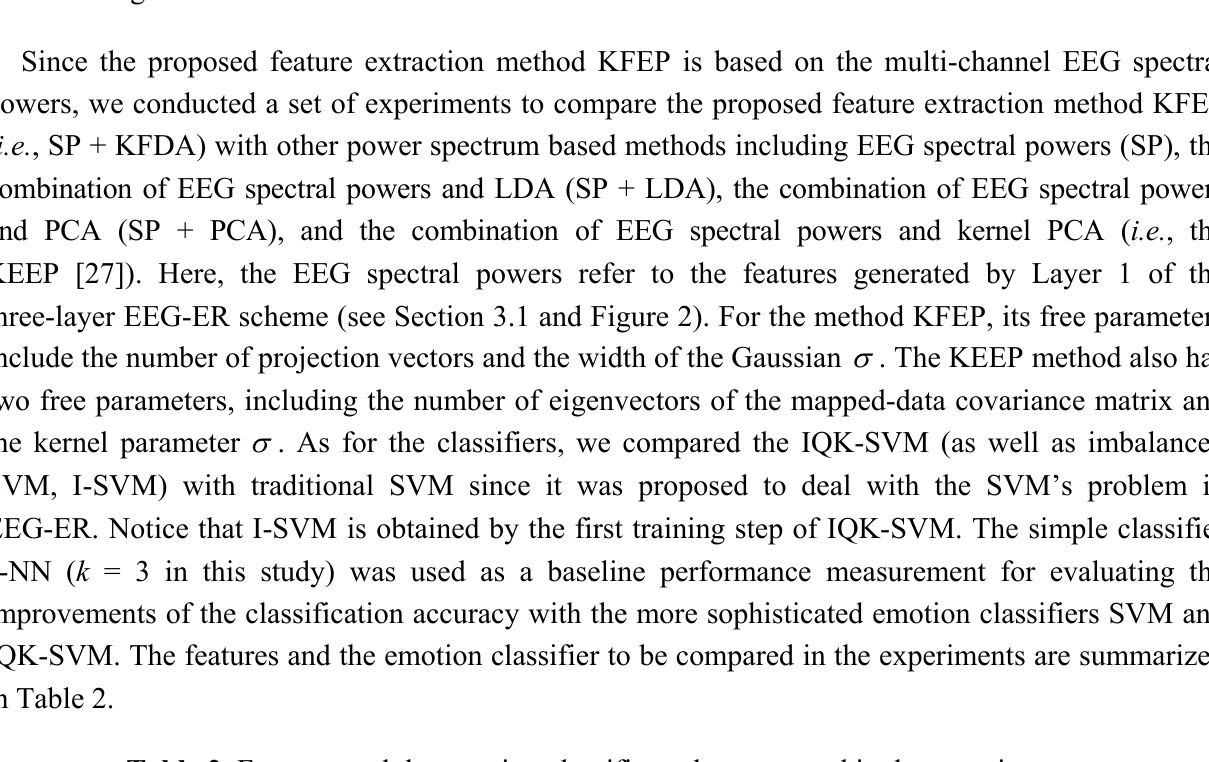
Table 2. Features and the emotion classifier to be compared in the